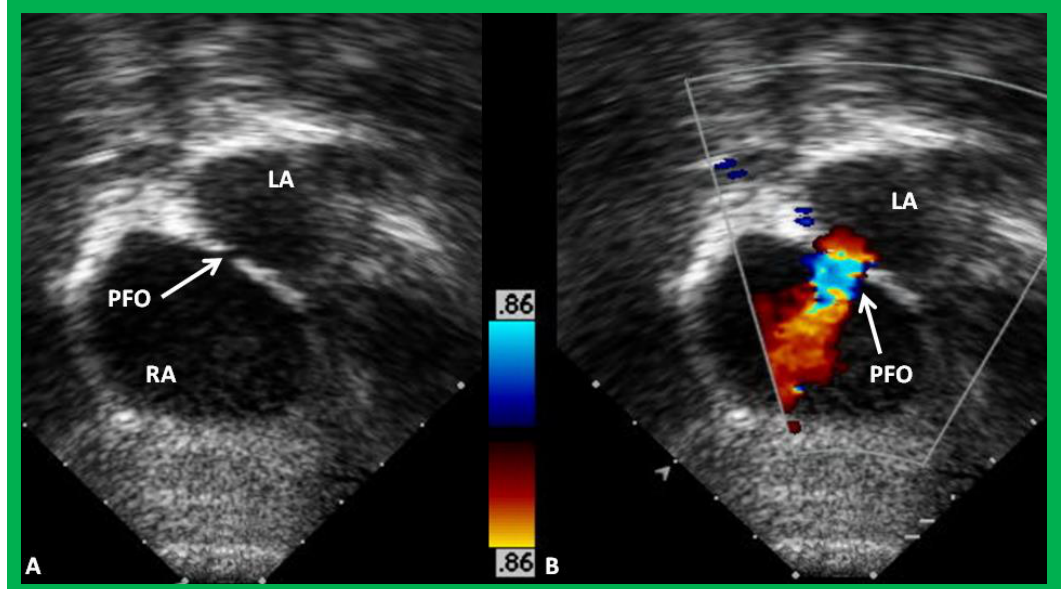
Figure 3. ( A ) . Selected video image from subcostal echocardiographic projection of a baby with mi- tral atresia demonstrating a small and restrictive patent foramen ovale (PFO) (arrow). ( B ) . Color flow Doppler illustrates color flow acceleration (arrow in ( B )) across the PFO. LA, left atrium; RA, right atrium. Reproduced from [7].